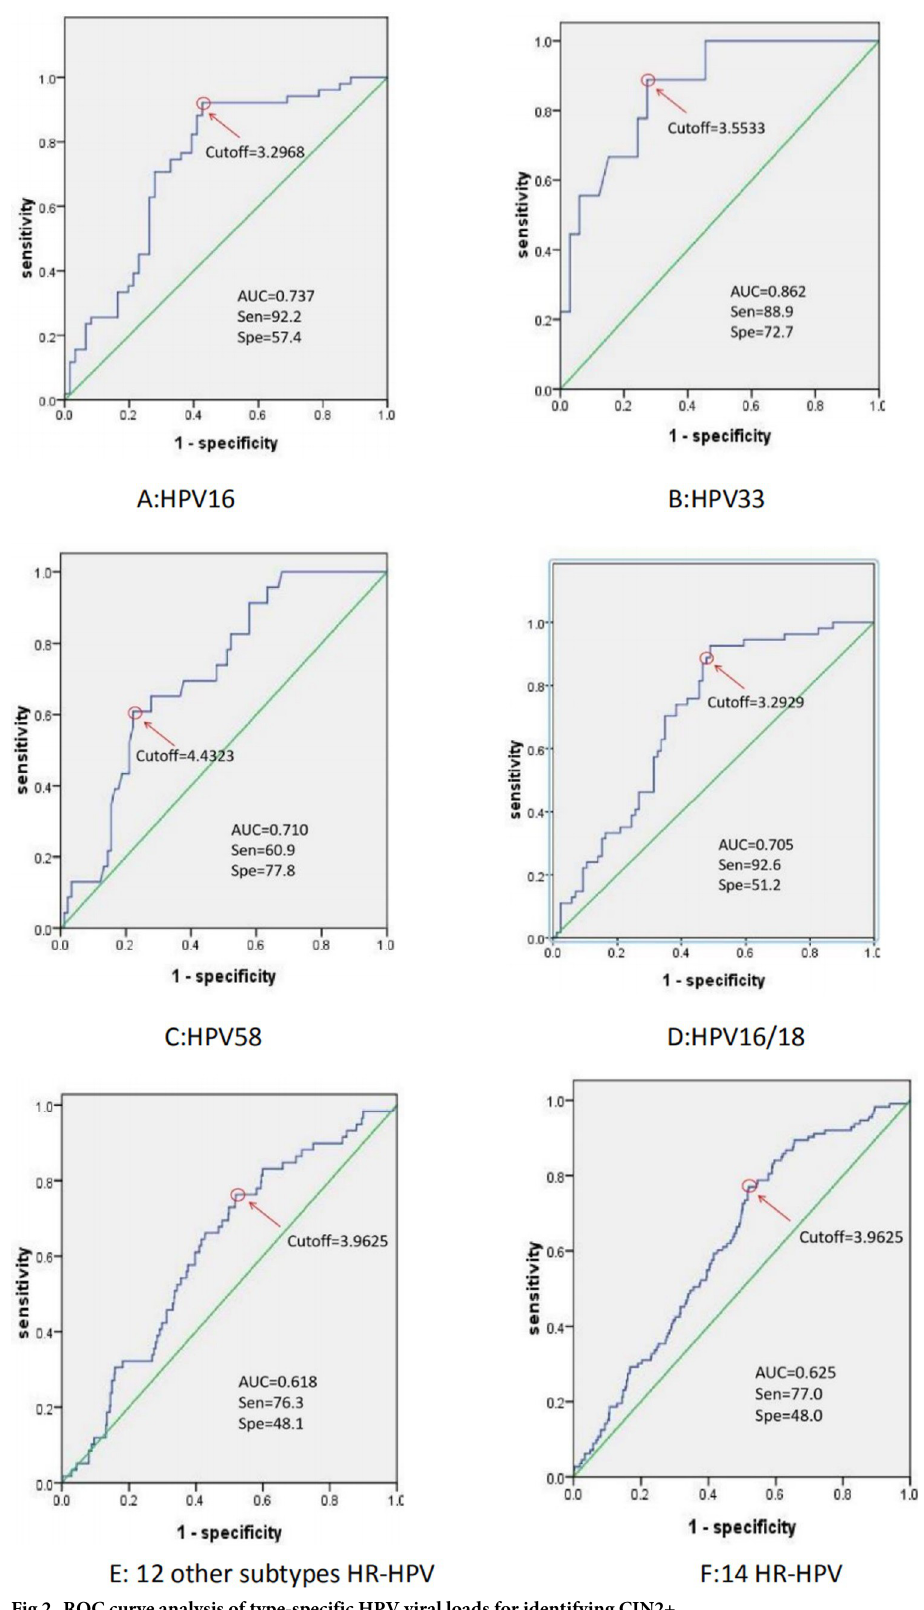
Fig 2. ROC curve analysis of type-specific HPV viral loads for identifying CIN2+.